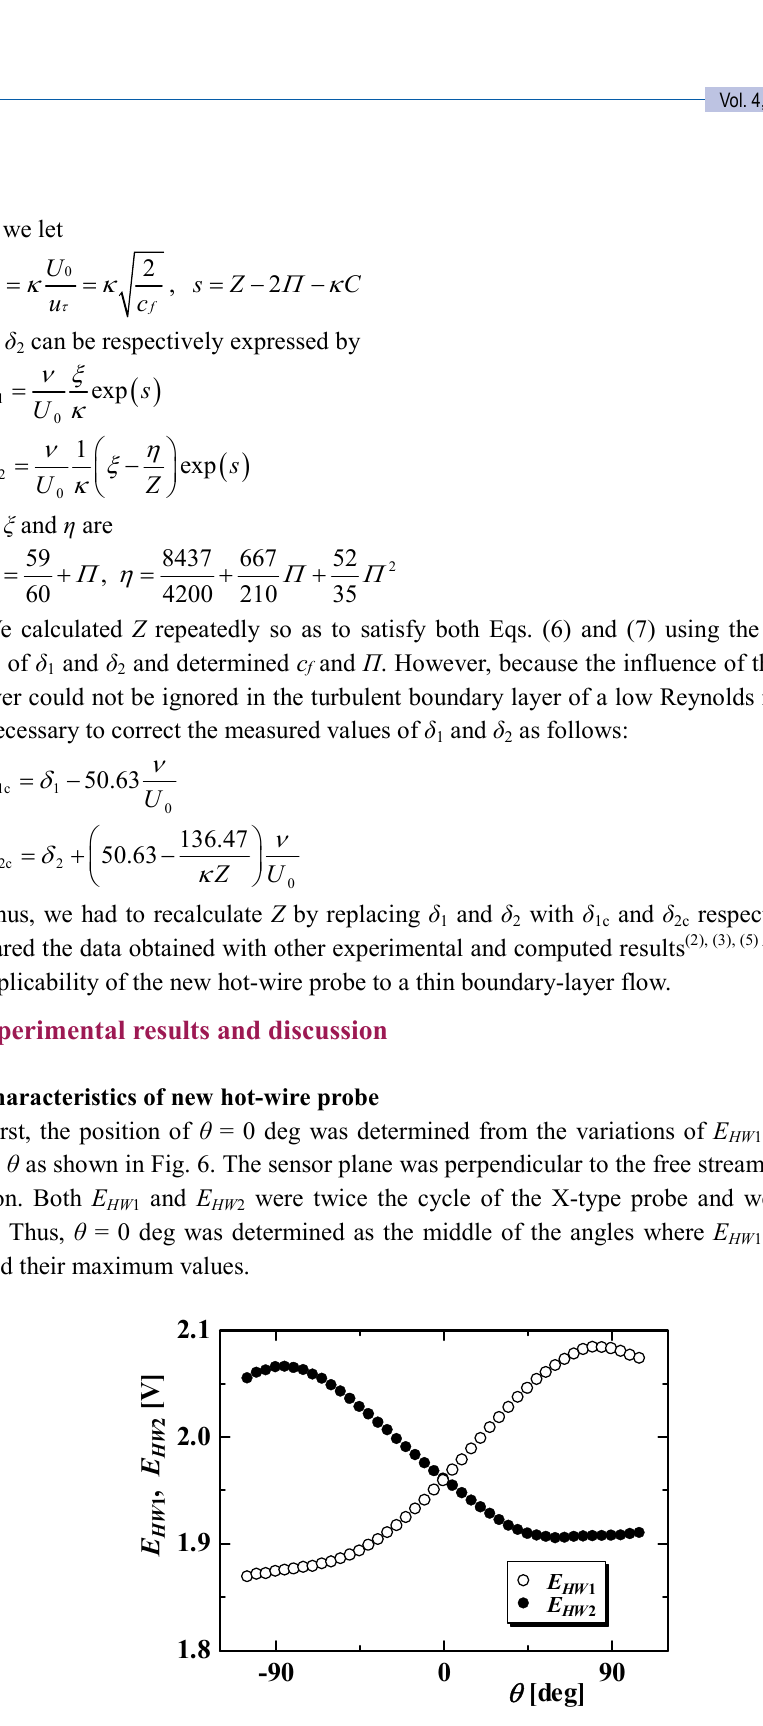
Fig. 6 Characteristic curves of each output of CTC to flow direction at E E were examined, all of them , 2 HW HW 2 E Σ plotted versus 04 . U at θ = 0, − 30 and − 70 deg. At θ = 0 deg, HW θ 2 E Σ increased linearly with 04 . U , similar to the case of an I-type probe. As θ HW θ